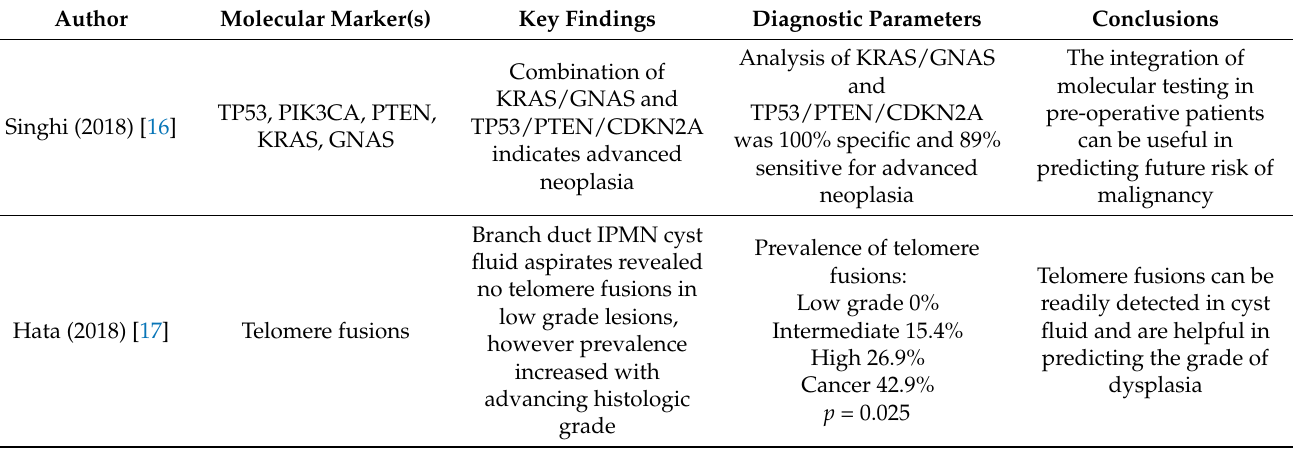
Table 2. Overview of reviewed studies regarding the use of cyst fluid for risk stratification of branch duct